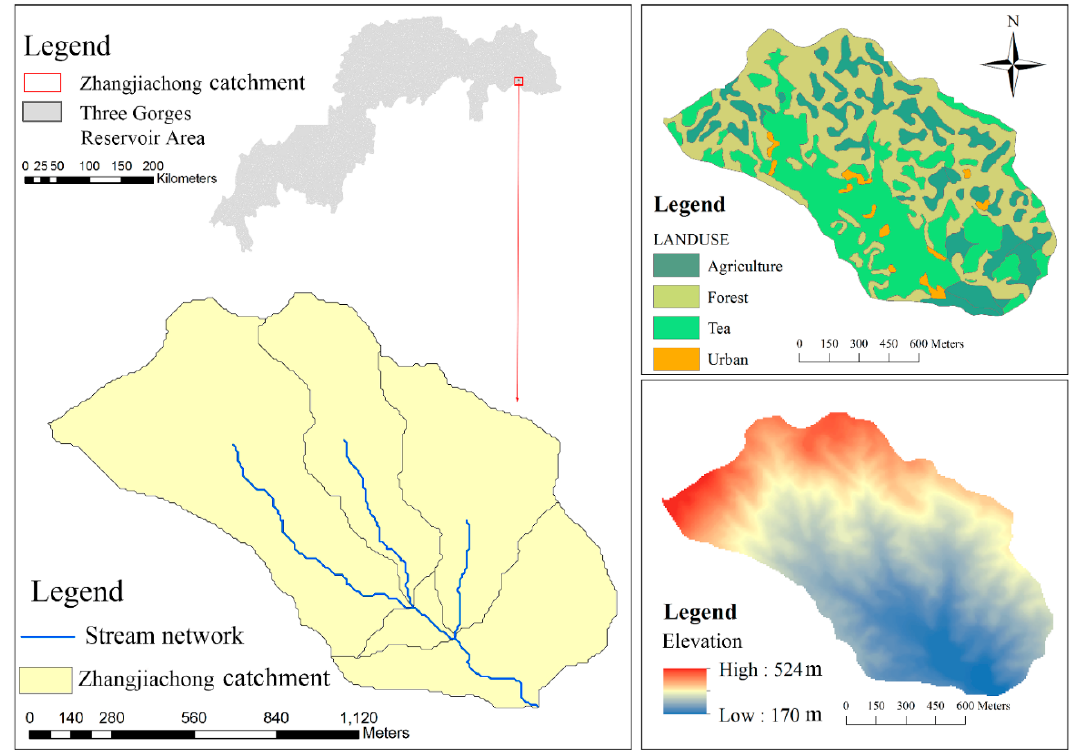
Figure 1. Location, land use, and elevation of the Zhangjiachong catchment.